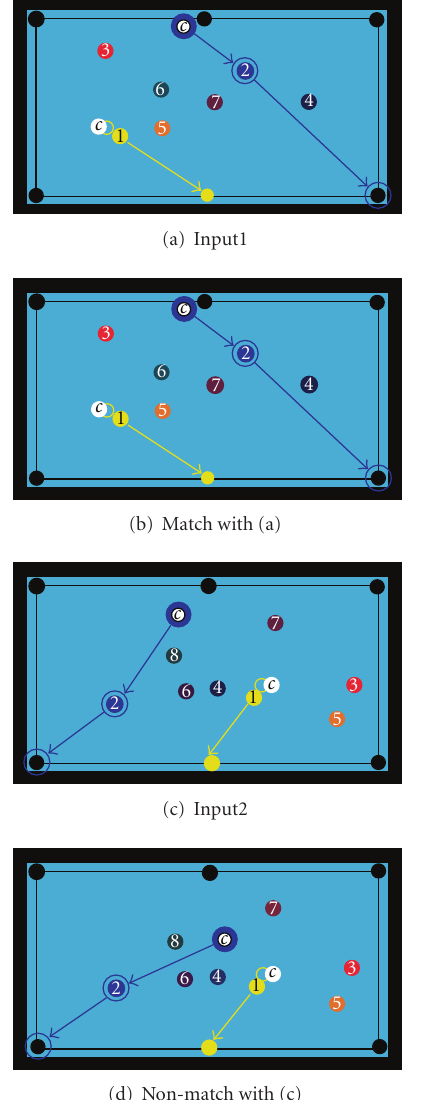
Figure 18: Influence of the error.